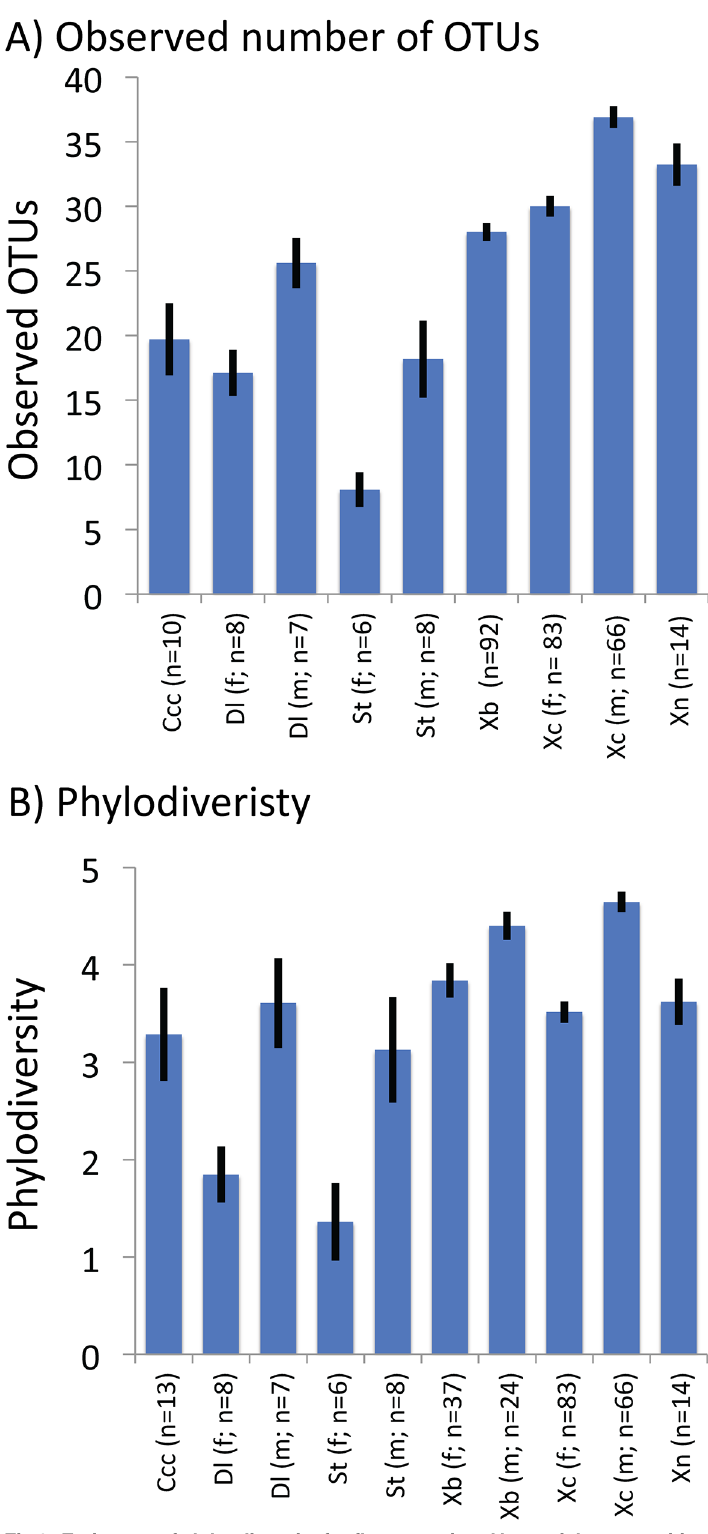
Fig 2. Estimates of alpha diversity for flea-associated bacterial communities. Alpha diversity was measured as the total number of observed OTUs detected in a subset of 1000 randomly chosen sequences